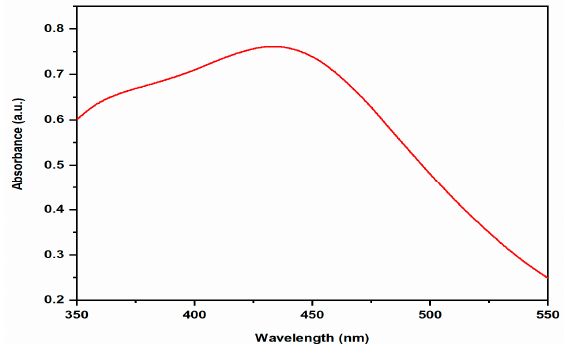
Figure 2. UV-vis absorption spectra of AgNPs. Figure 2. UV ‐ vis absorption spectra of AgNPs.